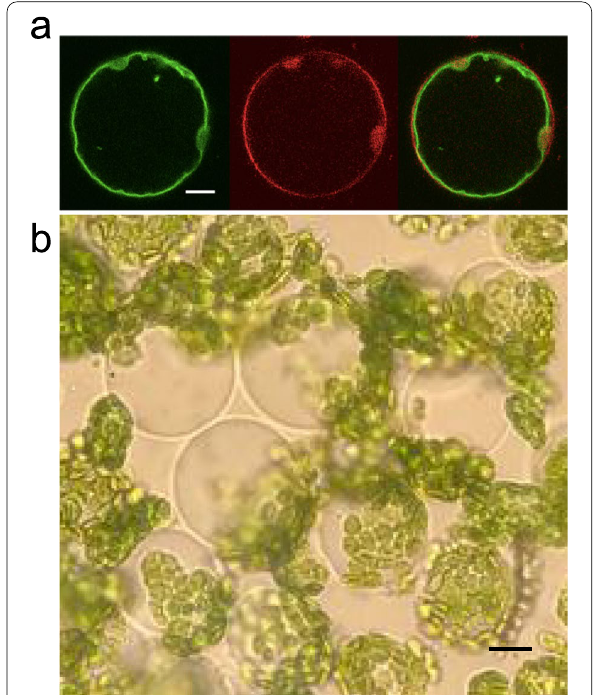
Fig. 1 The plant vacuole can occupy most of the intracellular volume and is easy to isolate. a Confocal images showing an Arabidopsis thaliana mesophyll protoplast transiently expressing a tonoplast-localized AtTPC1-EGFP fusion protein (left, green signal) and stained with the plasma membrane marker FM4–64 (middle, red signal). The right panel displays merged signals. Scale bar 7 μm (see Supplemental material of Picco et al. 2015 for experimental details). b Protoplasts from Arabidopsis mesophyll cells were obtained by enzymatic treatment with cellulase and pectolyase (Scholz-Starke et al. 2006). Upon application of the vacuole release solution VRS (see text) they burst and release the vacuoles. Scale bar 10 μm